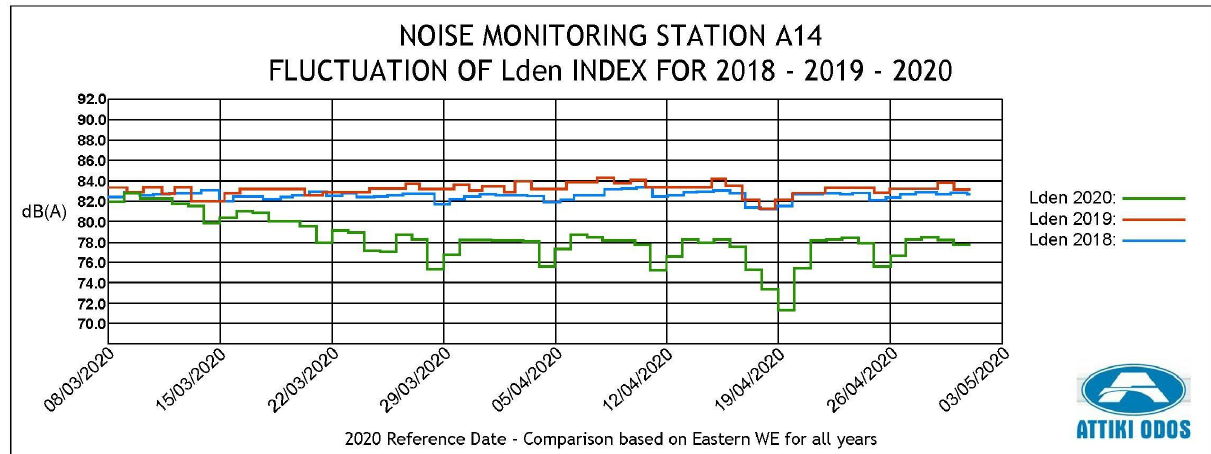
Figure 9f: Fluctuation of L den index – Noise monitoring station